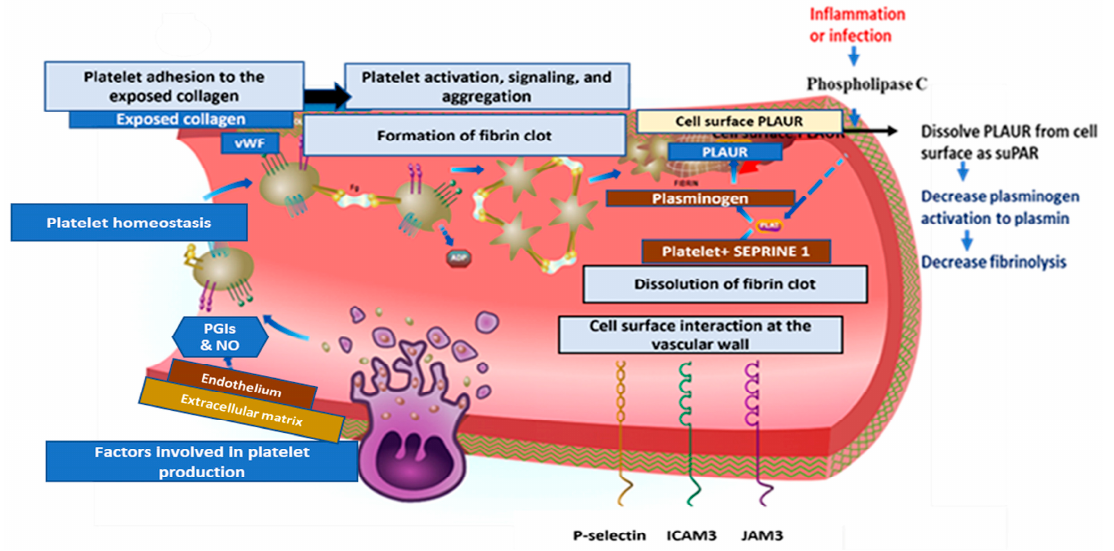
Figure 8. PLAUR targeted pathways generated by the cBioPortal database and Reactome (PB | Hemostasis (reactome.org) (last accessed 3 March 2023).